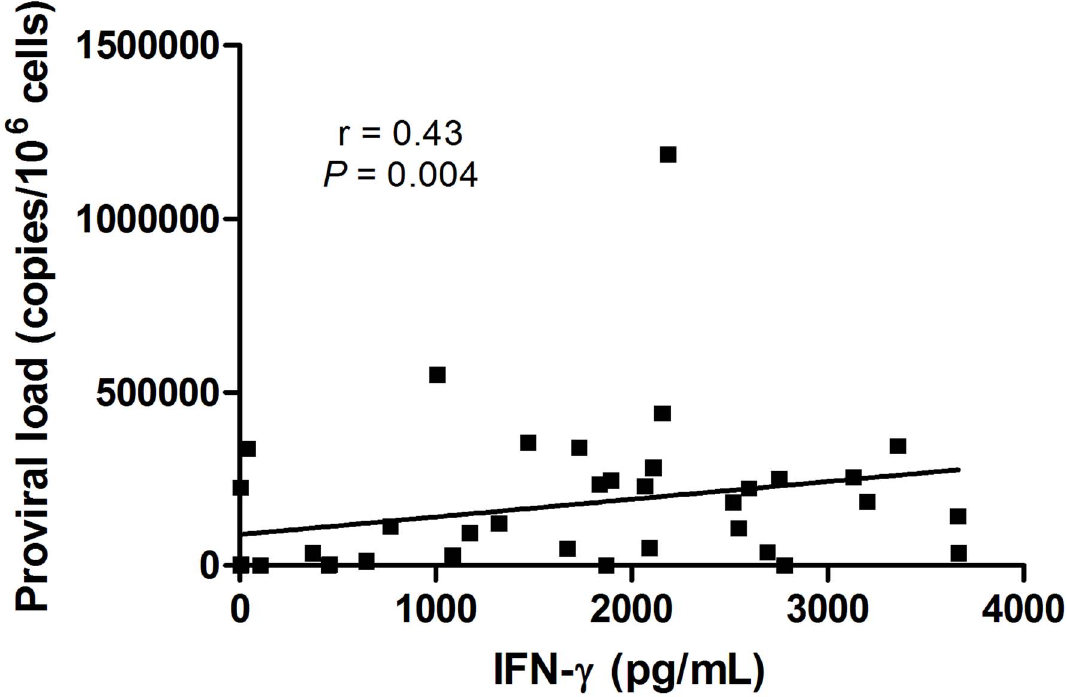
Fig. 6. Correlation between proviral load and IFN- c produced by PBMCs from HTLV-1 infected subjects. Correlation between proviral load of HTLV-1 infected subjects and IFN- c production by PBMCs (n=40). Spearman correlation and r significance test were used for statistical analyses ( P , 0.05).